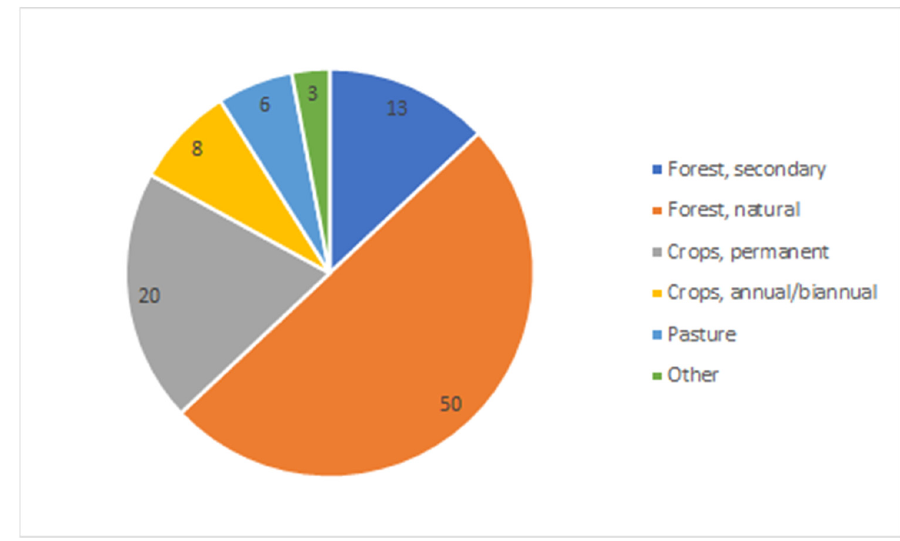
Figure 2. Percentage of land cover types on farms (<115 ha) in the Amazon region (0–2500 m) ac- Figure 2. Secondary forest stages (stacked column) and old-growth forest (dot) as a percentage in cording to the 2012 agrarian census [42] . 2008. YSF, young secondary forest ( ≤ 20 years); MSF, mid (20–60 years); OSF, old (60–100 years); OG, old-growth (>100 years) forest. Original data are from [46] based on a chronosequence in a network of ground plots across Latin America and the Caribbean